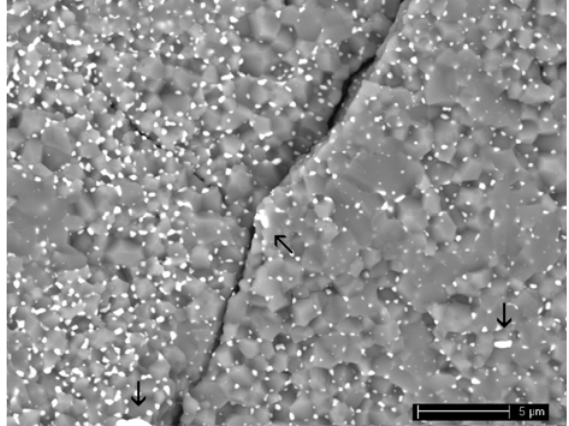
Figure 2. Low-magnification image of AZ5, obtained by uniaxial pressing of granulated